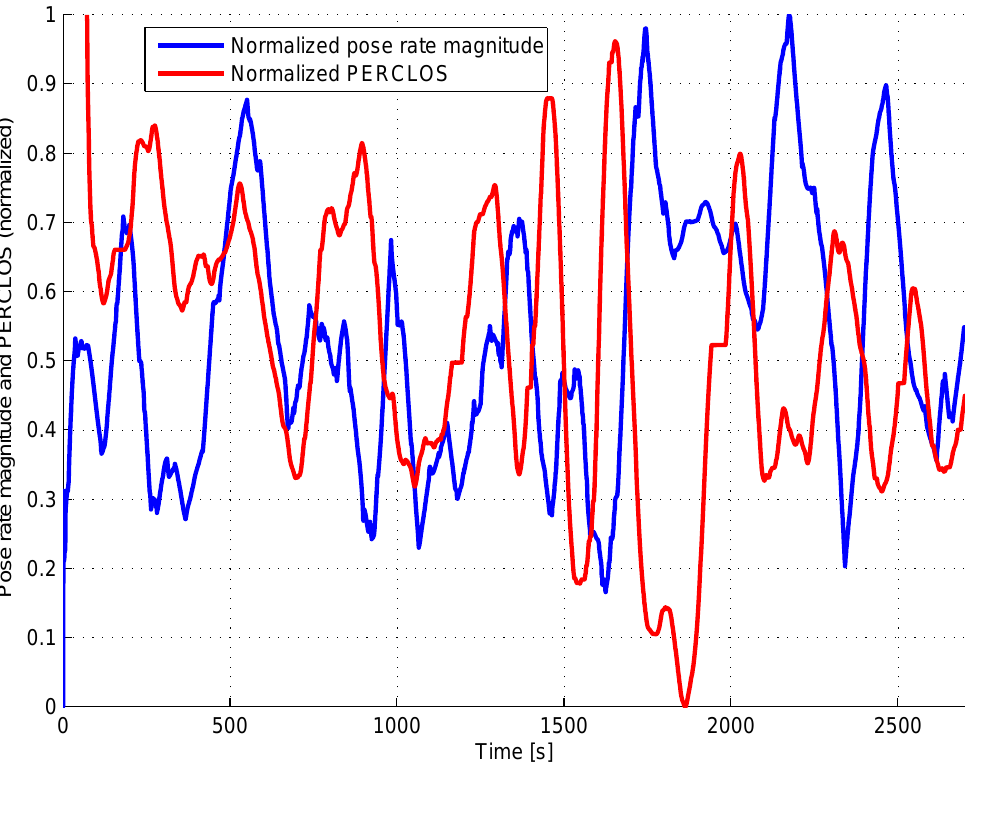
Table 3. PERCLOS threshold values for driver state classification using 60 seconds